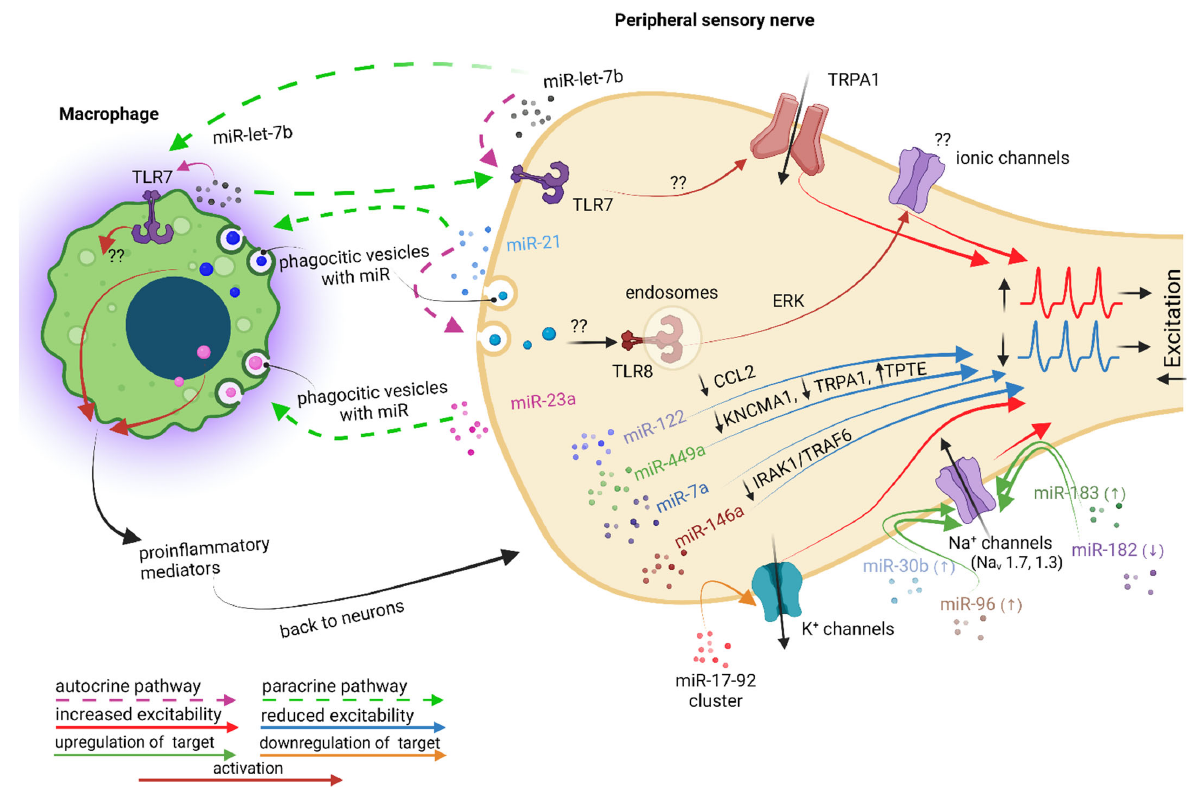
Figure 6. Illustration of the pro ‐ and anti ‐ nociceptive dialogue between macrophages and peripheral sensory neurons mediated (or putatively mediated) by miRNAs after traumatic peripheral nerve injury. Traumatically lesioned neurons release miRNAs that have pro ‐ nociceptive effects, exerted via macrophages or in an autocrine manner, back on neurons. miR ‐ 21 and miR ‐ 23 released by le ‐ sioned neurons are engulfed my neighboring macrophages, at the level of which promote the M1 switch and downstream secretion of pro ‐ inflammatory primary mediators, which act back on neu ‐ rons to increase their excitability. The miR ‐ 17 ‐ 92 cluster and miRs ‐ 39b, ‐ 96 and ‐ 183 released by lesioned neurons seem to act in an autocrine manner on neurons, where they induce increased ex ‐ citability via the downregulation of K v ion channels or the upregulation of Na v ion channels, respec ‐ tively. A similar effect on Na v ion channels is induced by a reduced expression of miR ‐ 182. miR ‐ let ‐ 7b is the only one proved to be secreted both by neurons and macrophages, but its role in traumatic induced neuro ‐ immune communication is putative, since there are not enough experimental data. Lesioned neurons also secrete anti ‐ nociceptive miRNAs (i.e., miR ‐ 122, miR ‐ 449a, miR ‐ 7a and miR ‐ 146a) for which the analgesic effects were proved together with the signaling pathways they acti ‐ vate, although the final molecular target is not yet clear.